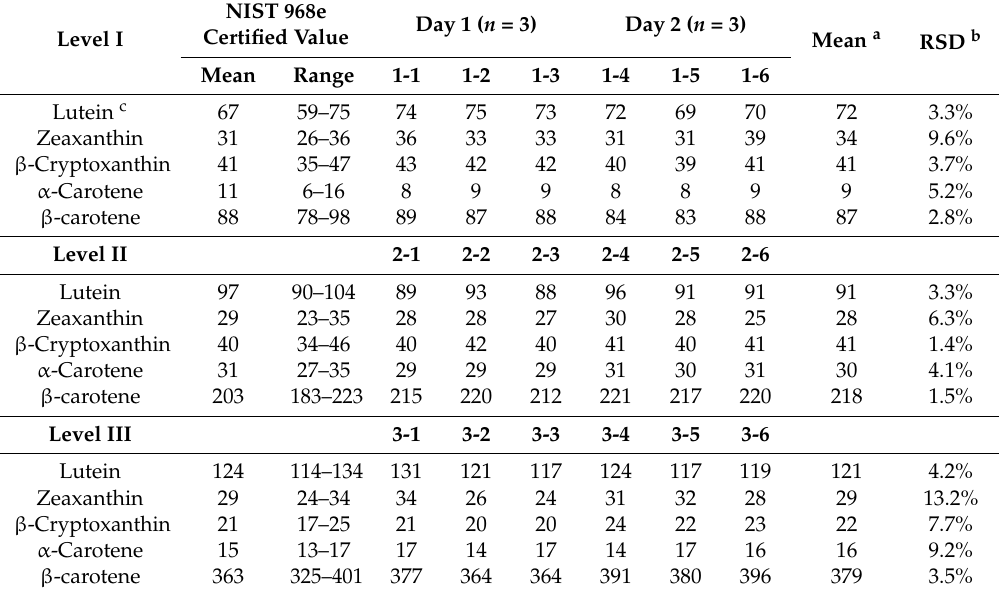
Table 1. National Institute of Standards and Technology (NIST) Standard Reference Material 968e analysis results for serum (unit: ng/mL in